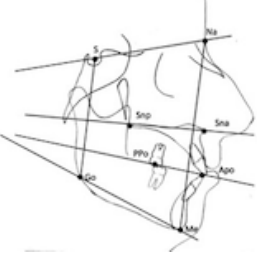
Figure 2. Cephalometric parameters considered.